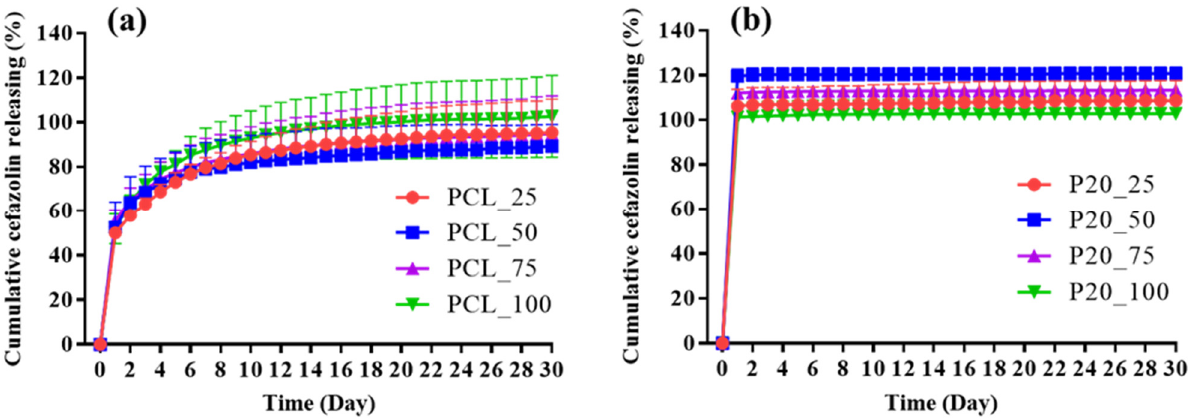
Figure 5. Cumulative cefazoline release profile of cefazolin loaded samples in aCSF solution: ( a ) Cefazolin loaded PCL; ( b ) cefazolin loaded ORC/PCL bilayered composites. Data are expressed as mean ± standard deviation (SD).